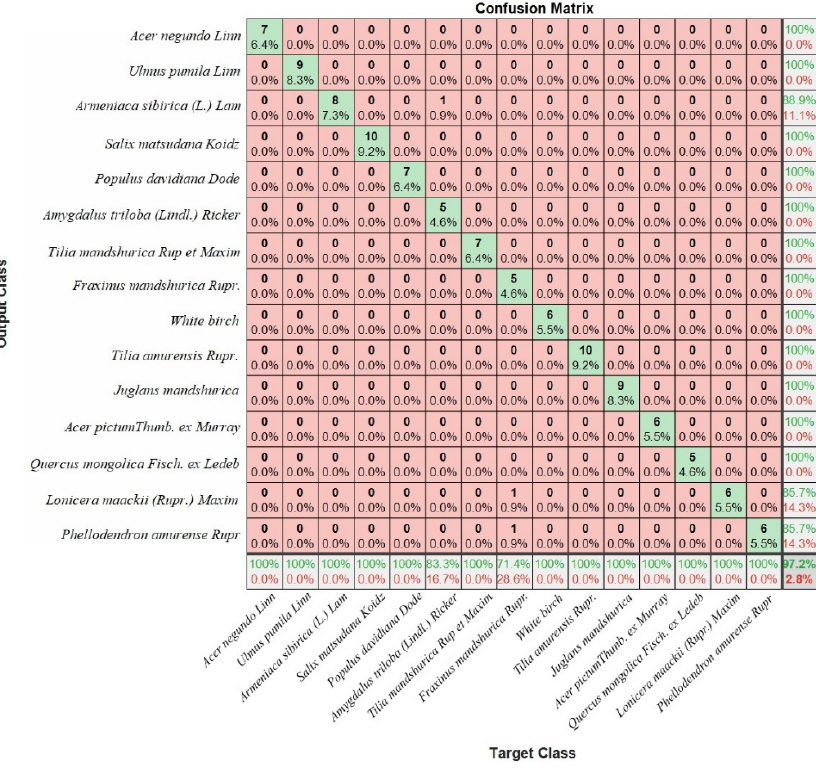
Figure 17. The confusion matrix of leaf small datasets by using ES-ResNet50.